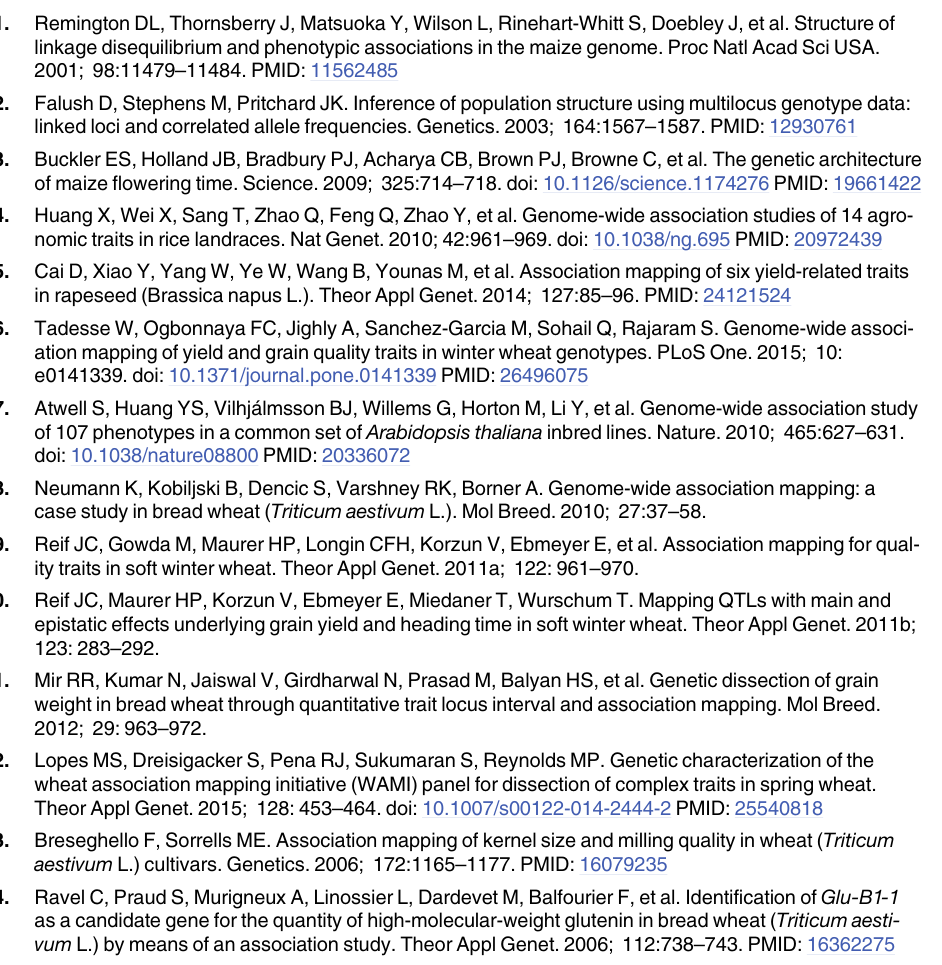
S4 Table. 56 important MTAs identified by different GWAS approaches along with inter- acting